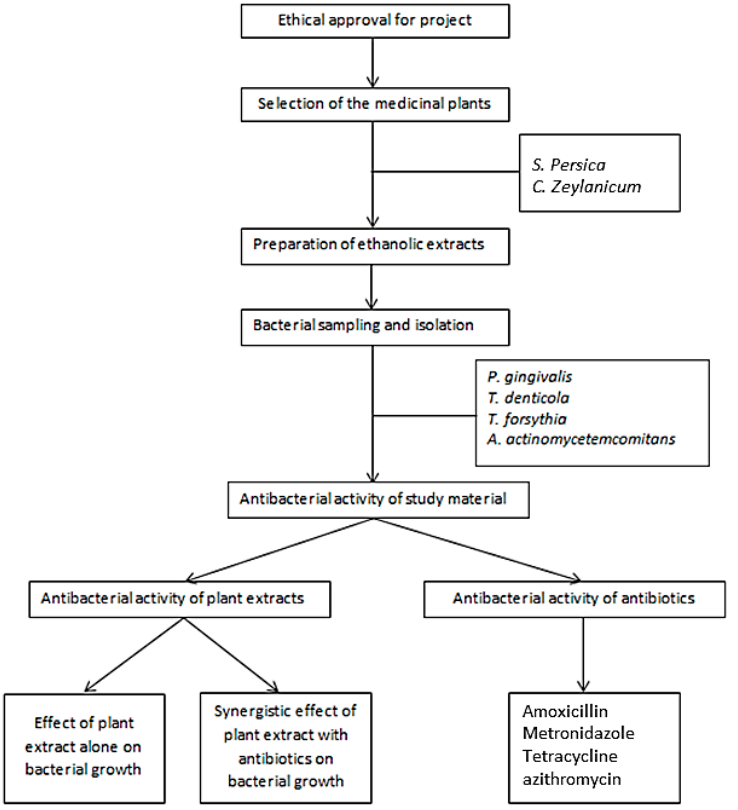
Figure 1. Flow chart of the study design.